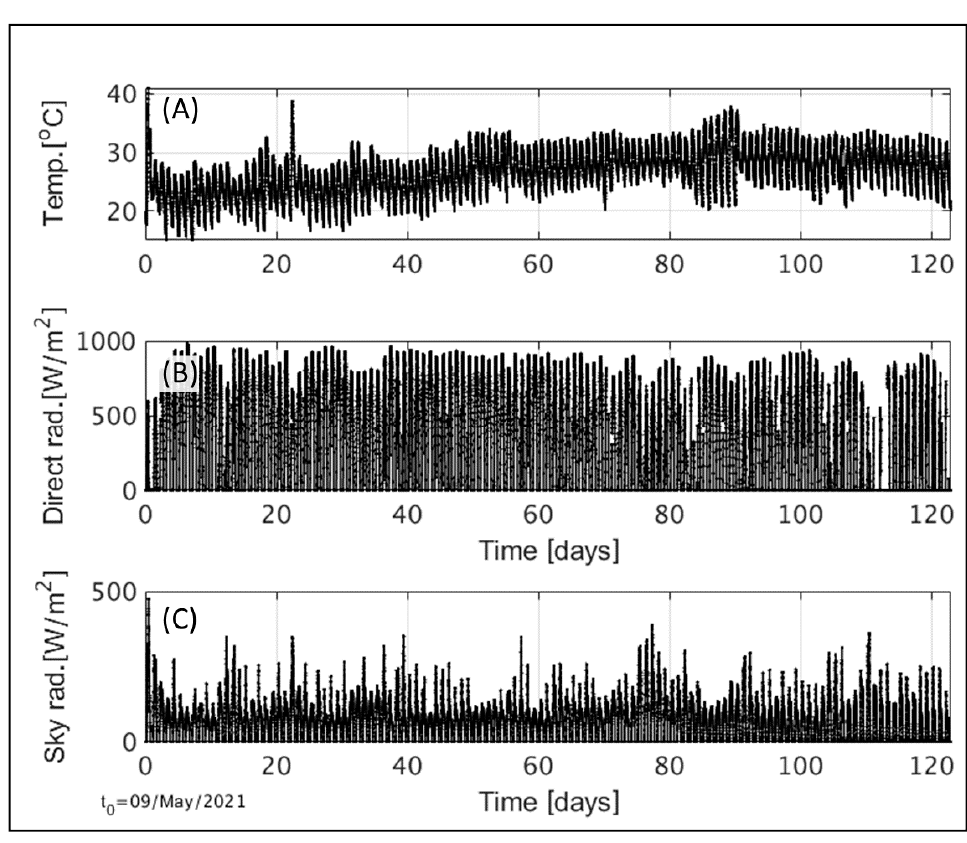
Figure 5. Environmental conditions during the experiment, measured ~1 km north of the roof location, from 9 May 2021 to 9 September 2021. ( A ) Temperature in shade, ( B ) direct sun radiation, and ( C ) diffuse sky radiation.